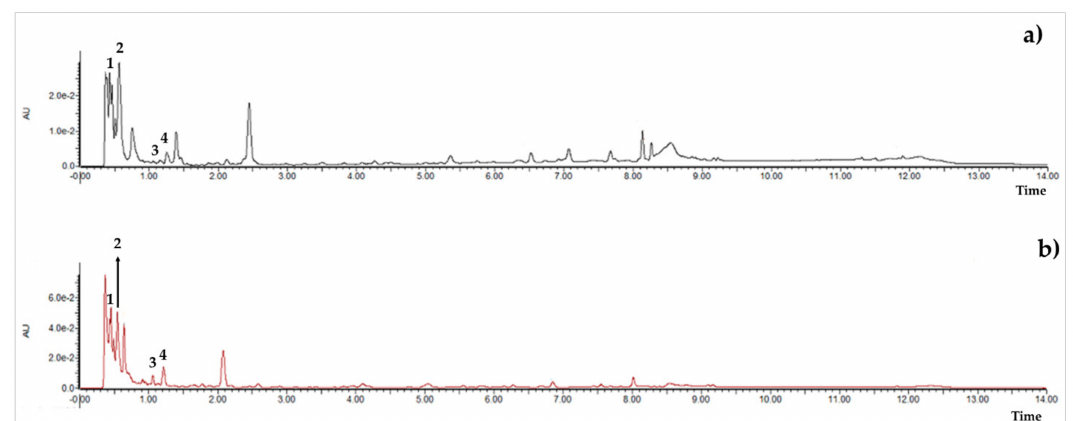
Figure 3. UPLC chromatograms of the phenolic compounds present in the uncleared extract ( a ) and clarified ( b ) at 280 nm, [y axis = intensity (absorbance unit, AU); x axis = retention time (min)]. Peaks: